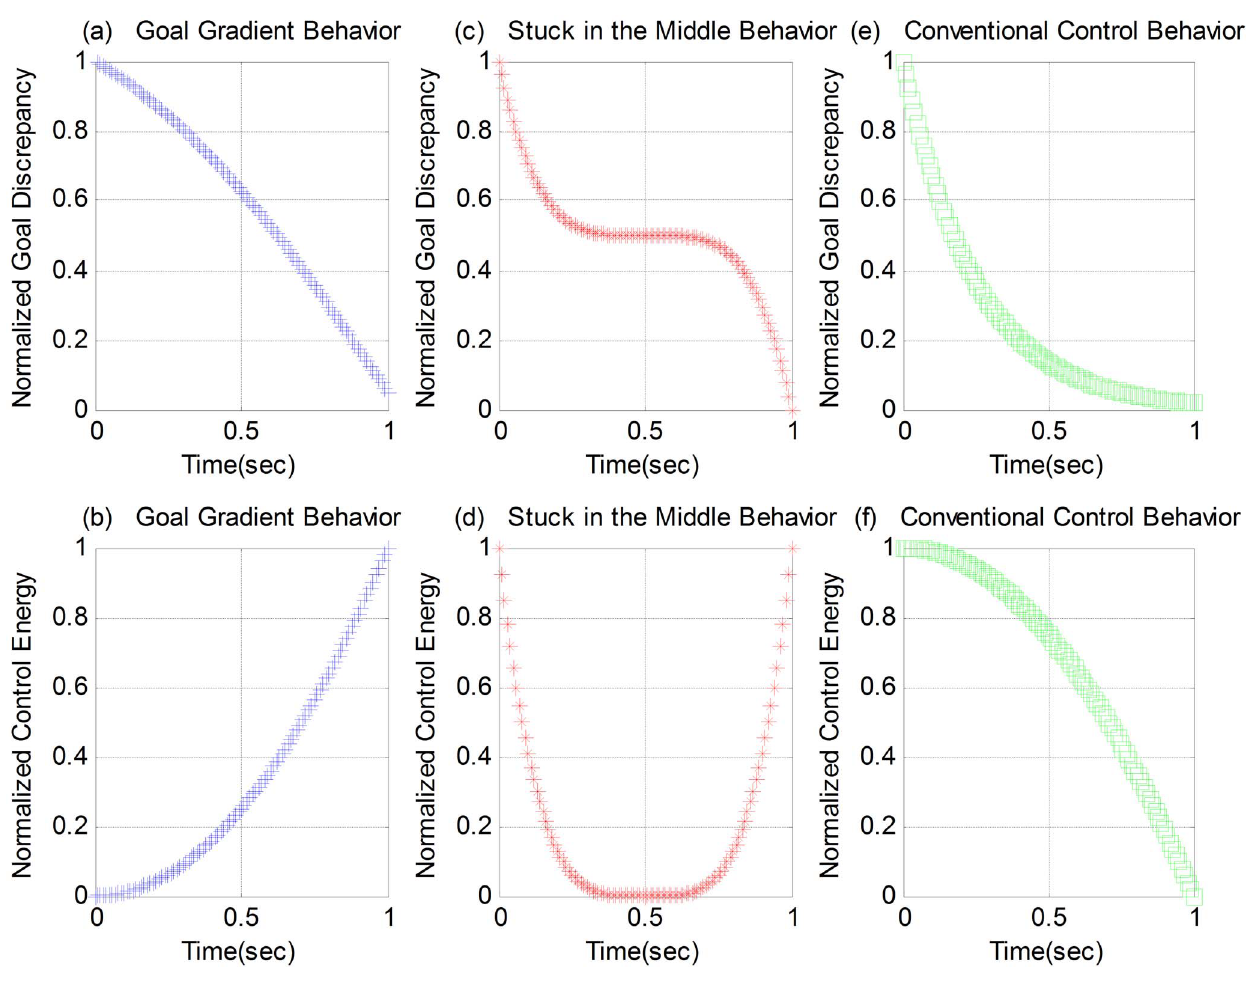
Figure 1. Three Different Behaviors: GGB, SMB and CCB.